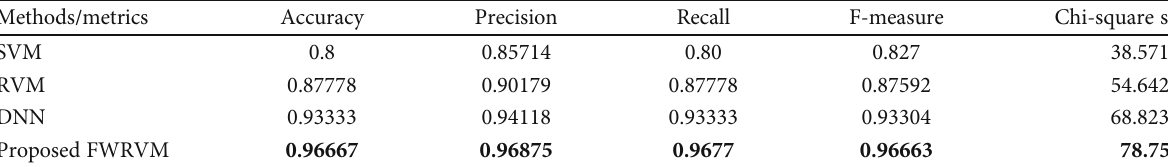
Table 4: Summary of performance results.